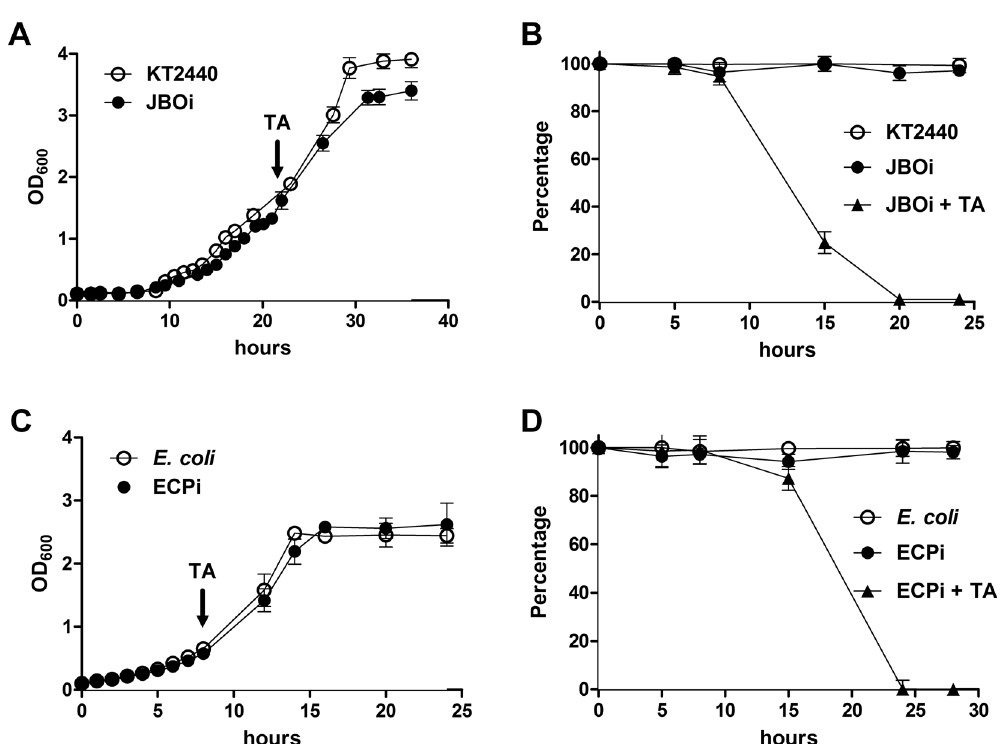
Figure 3. Growth profile of P . putida KT2440 and JBOi strain ( A ) and E . coli and ECPi strain ( C ) in minimal medium supplemented with 4 (g/L) glycerol. Cell lysis response of P . putida KT2440 and the engineered JBOi strain ( B ), and E . coli and ECPi strain ( D ). Arrows indicates addition of 5 mM of m -toluic acid